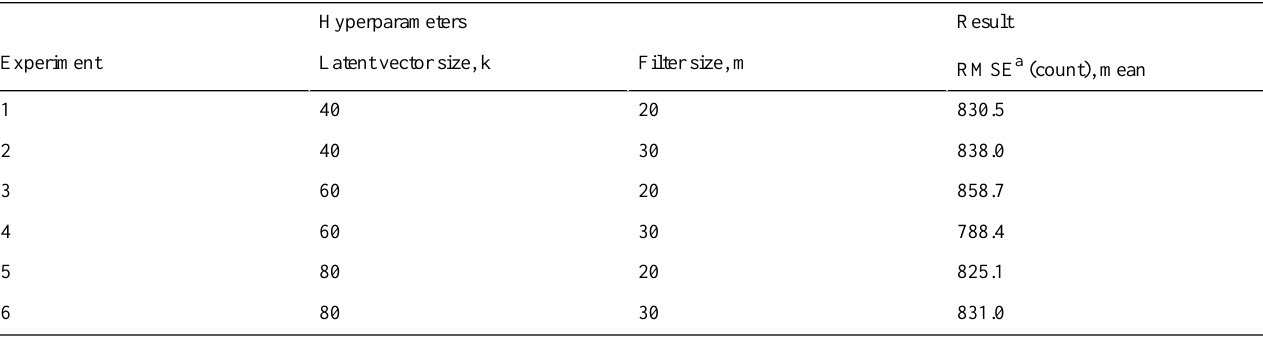
Table 2. Result of 10-fold cross-validation.